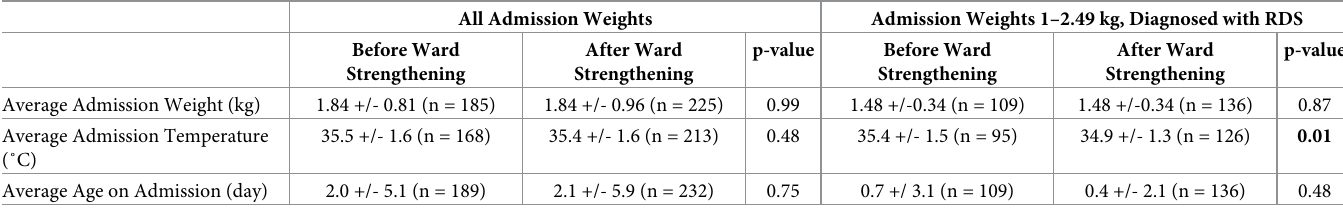
Table 4. Comparison of average weights, temperatures, and age on admission for neonates treated one year before and after ward-strengthening program at dis- trict-level hospitals in Malawi (2017–2018). All Admission